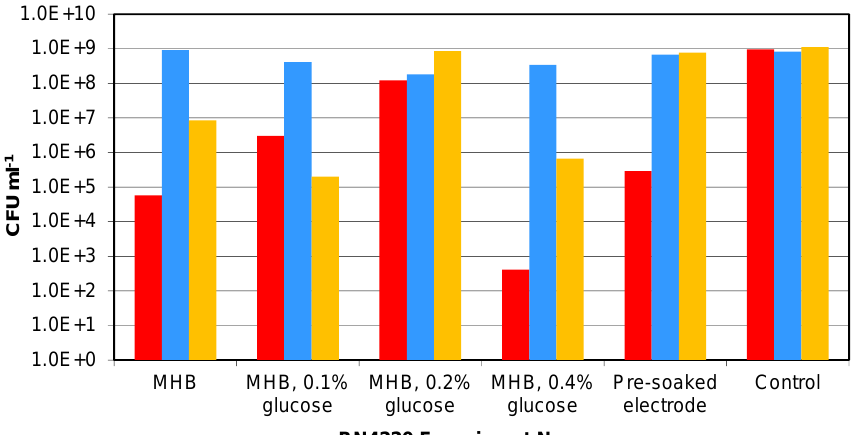
Figure 4. The final cell numbers of RN4220 in the parallel suspension experiment from low starting cell densities. Bar colours indicate sample number: Red—sample one; Blue—sample two; and Yellow—sample